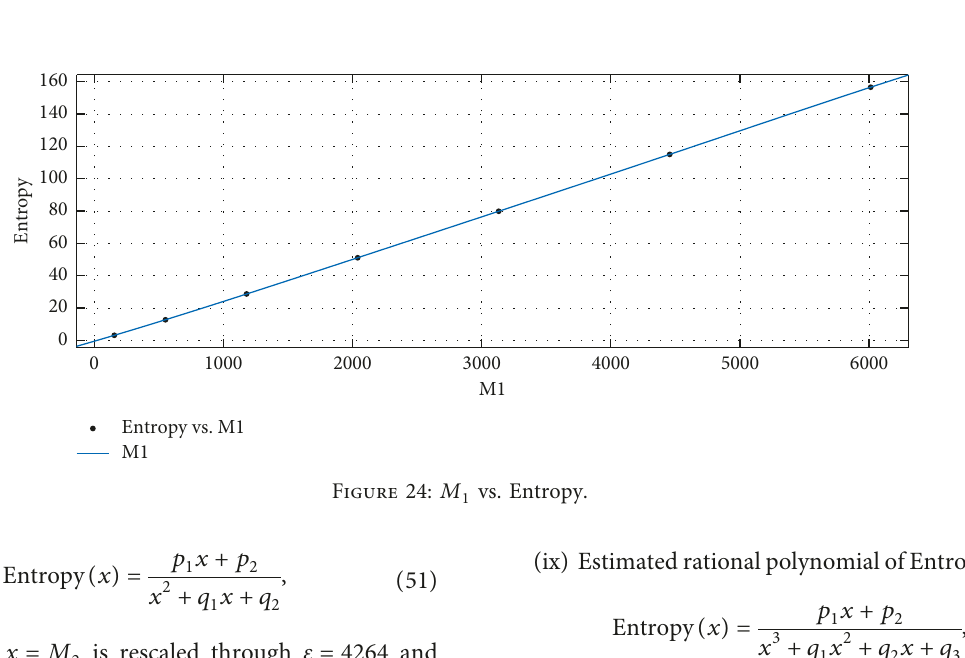
Figure 23: GA vs. Entropy.